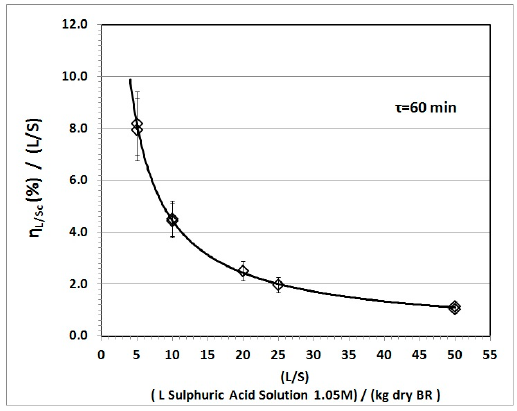
Figure 5. Variation of the η L/Sc (%)/(L/S) with L/S ratio, for C Af = 1.05 Μ , τ = 60 min, mechanical stirring, and ambient conditions.